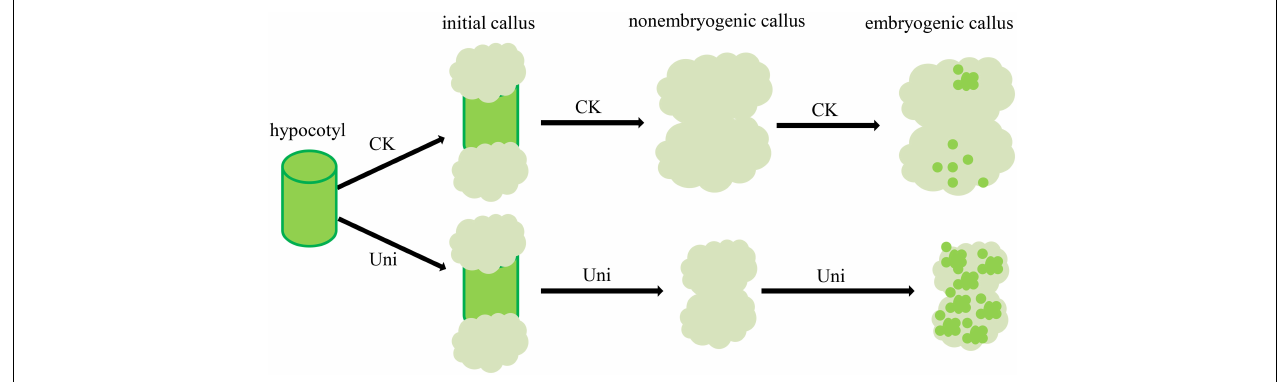
FIGURE 6 | A proposed model for the role of uniconazole during SE in cotton. Uniconazole inhibits the proliferation of callus and promotes EC